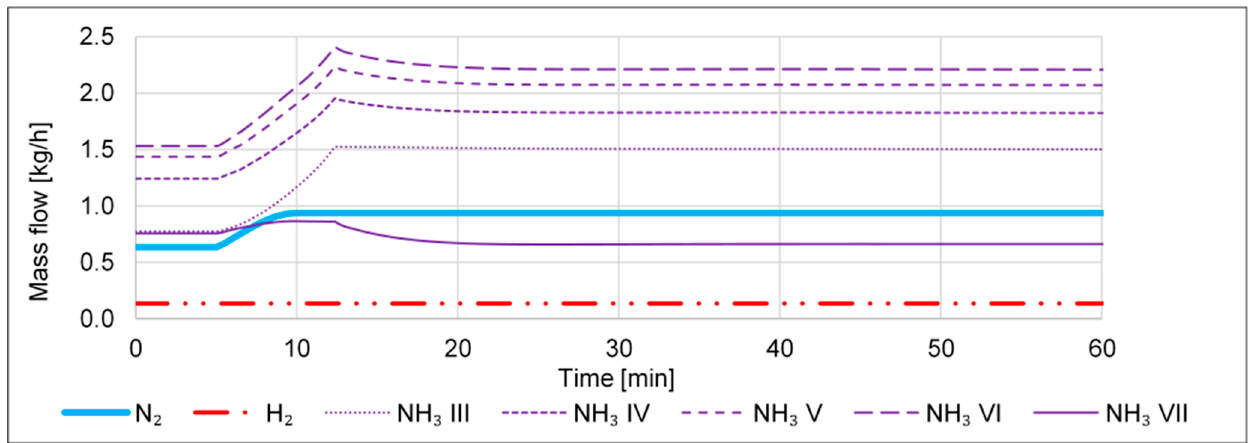
Figure 2 . Selected mass fl ows of scenario (a). Figure 2. Selected mass flows of scenario (a).